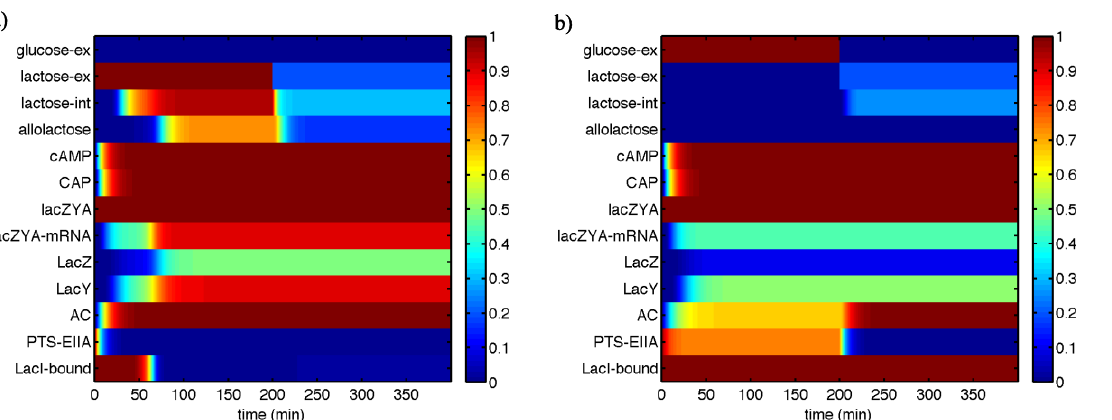
Figure 5: Bistable behavior of the fitted system: Growth on lactose (a) or glucose (b), then switch to low lactose (0.2) at time t=200min. The resulting steady states differ (indicating bistability) and depend on the previous growth conditions. Differences in the steady states are particularly significant for LacI-bound, LacY, LacZ and lacZYA_mRNA. The changes of the internal concentrations of allolactose and lactose are less pronounced (for the chosen parameter set) but still sufficient to establish two steady